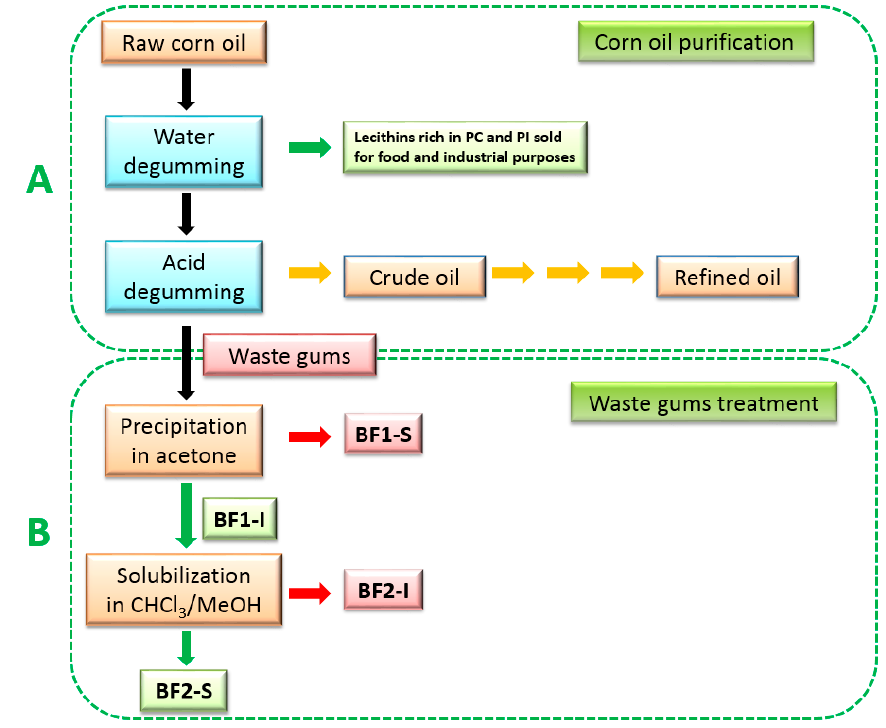
Figure 1. Pictures of the starting waste corn gums ( A ), the fraction BF2-S coming from the treatment process ( B ) and the PS-enriched BF2-S preparation ( C ).